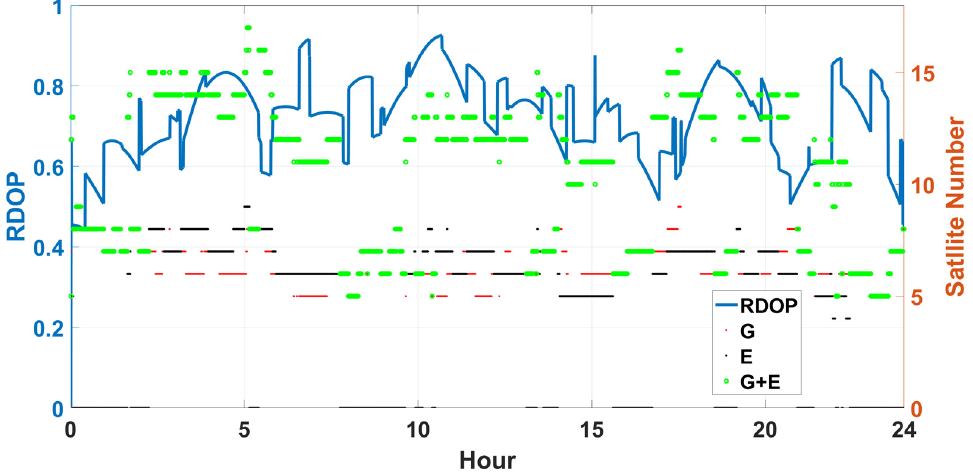
Figure 3. RODP and available satellites of BONE.